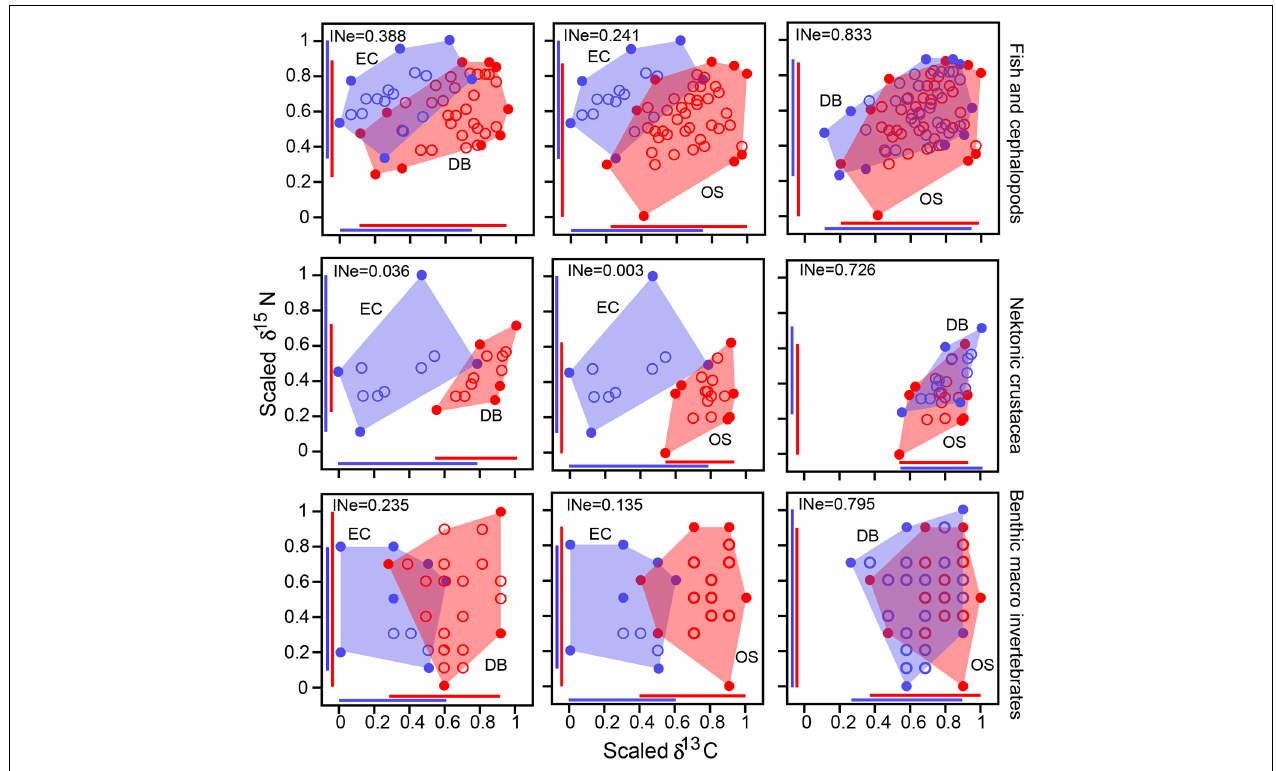
FIGURE 4 | Isotopic niche overlap and estimated isotopic nestedness (INe), illustrating greater resource sharing by highly mobile nekton than that of sessile consumers of three sites from Gwangyang Bay.